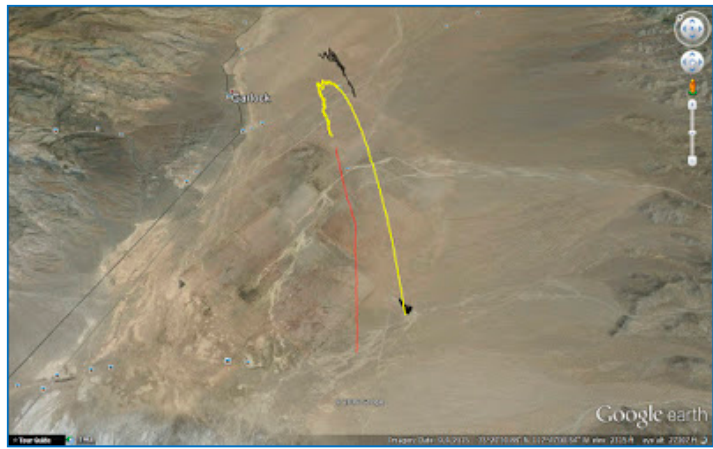
Figure 17. KLM file for Google Earth, Dataset 3. Source: [43].